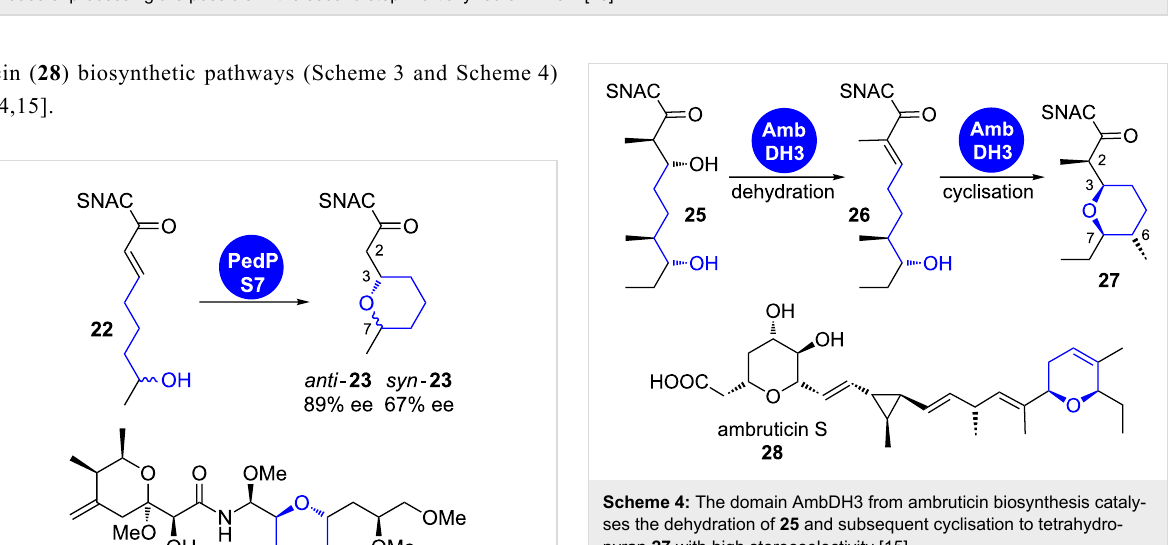
Scheme 2: Mechanisms for the formation of oxygen heterocycles. The degree of substitution can differ from that shown in the scheme. In b, other modes of processing are possible in the second step. Partially redrawn from [13].